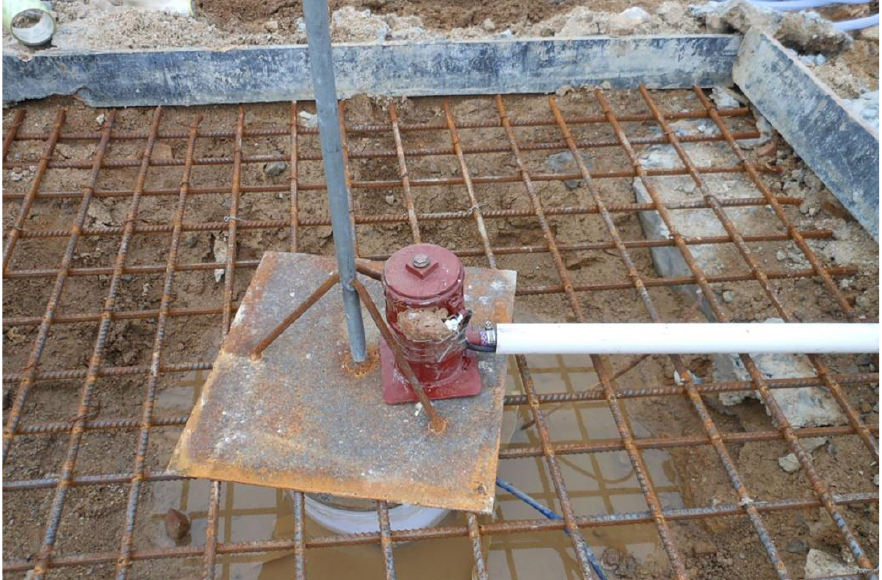
Figure 9. Installation of monitoring instruments. Table 4. Monitoring design parameters for each monitoring